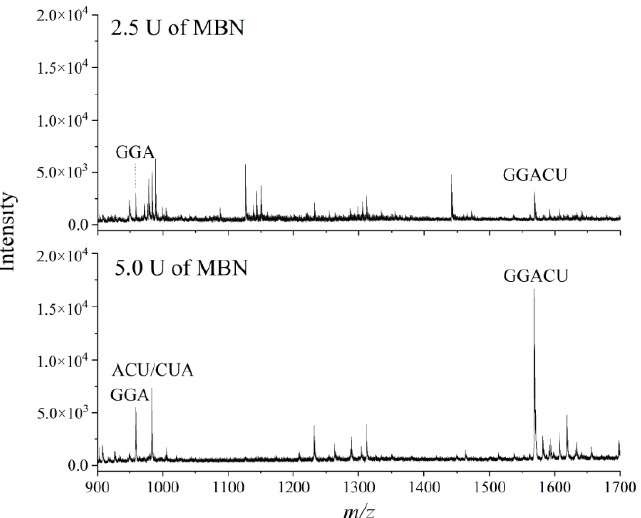
Figure 4. Representative mass spectra resulting from MALDI-MS following nuclease protection as- says using the ABzIM-ITO and a 15-mer RNA standard with an internal GGACU motif and different amounts of single-strand-specific MBN.